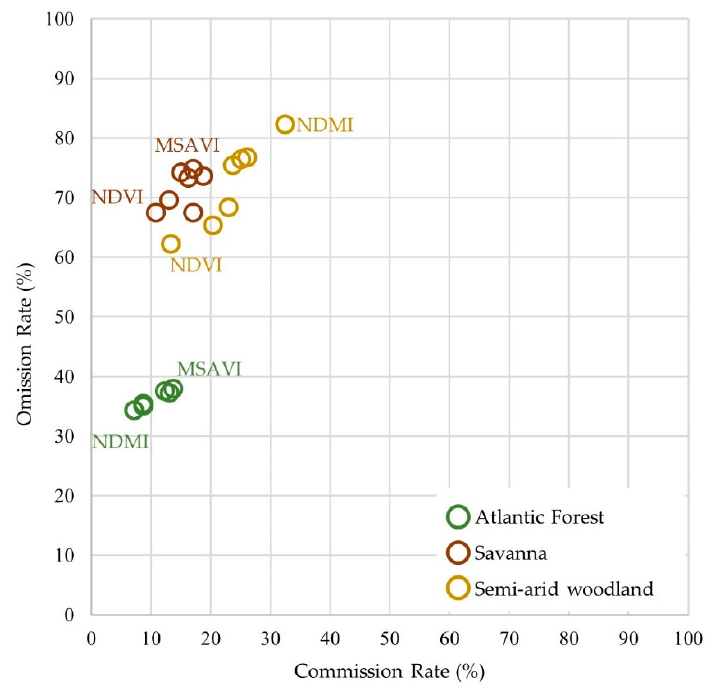
Figure 5. Omission and commission rates of the disturbances maps.